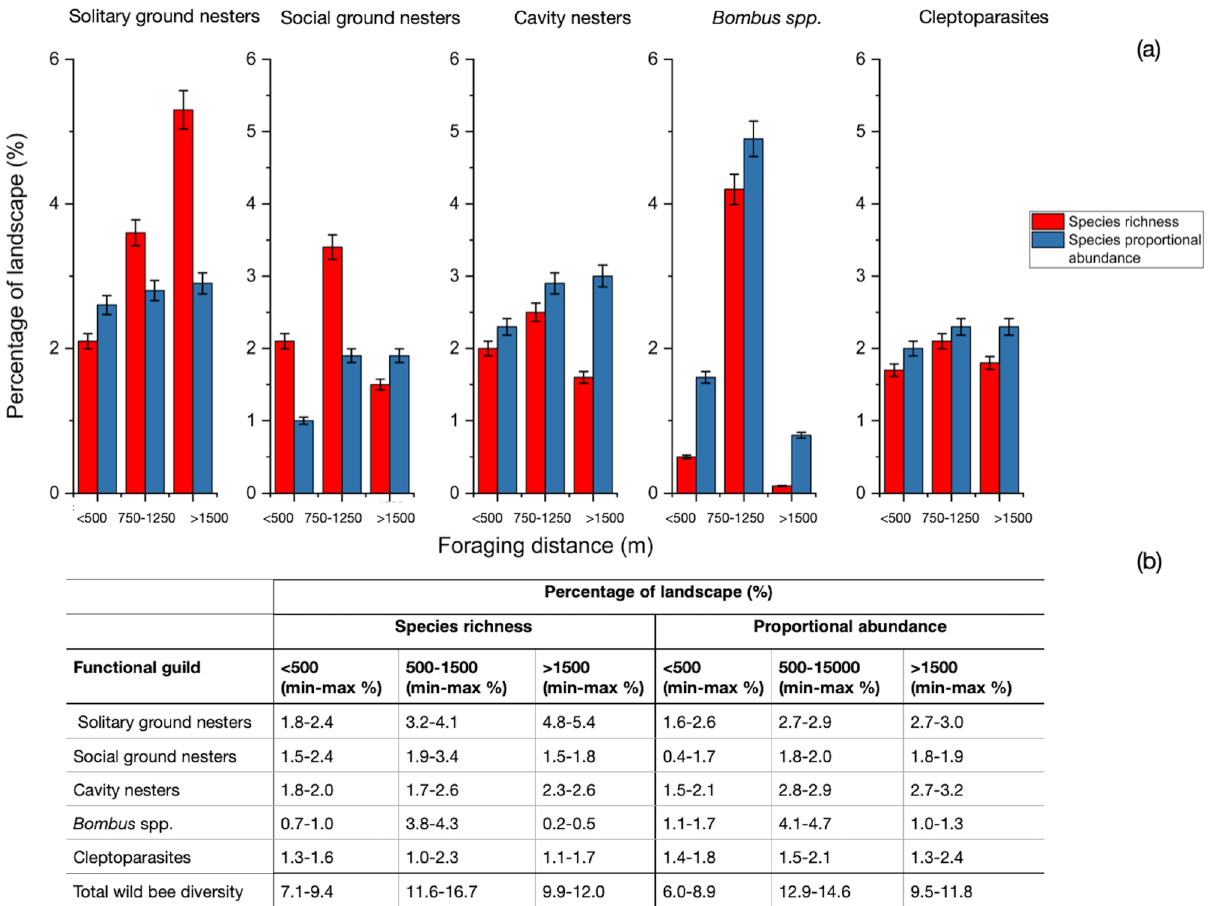
Figure 2. ( a ) The mean amount of habitats; ( b ) the maximum and minimum amounts of habitat within a landscape to maintain the species richness (red-) and proportional abundance (blue columns) of five functional bee guilds: solitary ground nesters, social ground nesters, cavity nesters, bumblebees ( Bombus spp. excluding subgenus Psithryus ), and cleptoparasitic species (including Bombus subg. Psithryus ) expected community parameters at each foraging category (< 500 m, between 500 and 1500 m, and > 1500